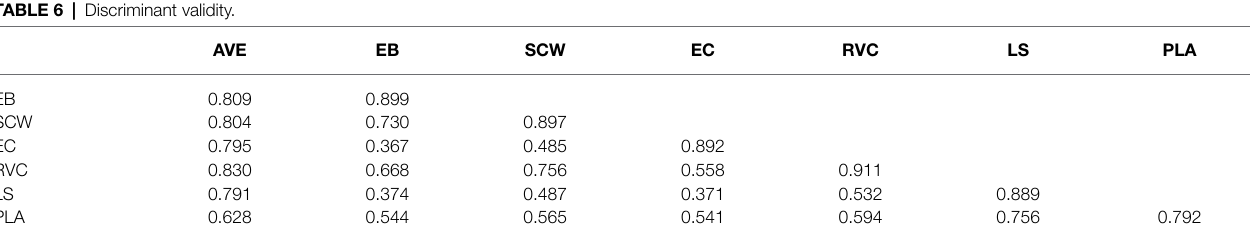
TABLE 6 | Discriminant